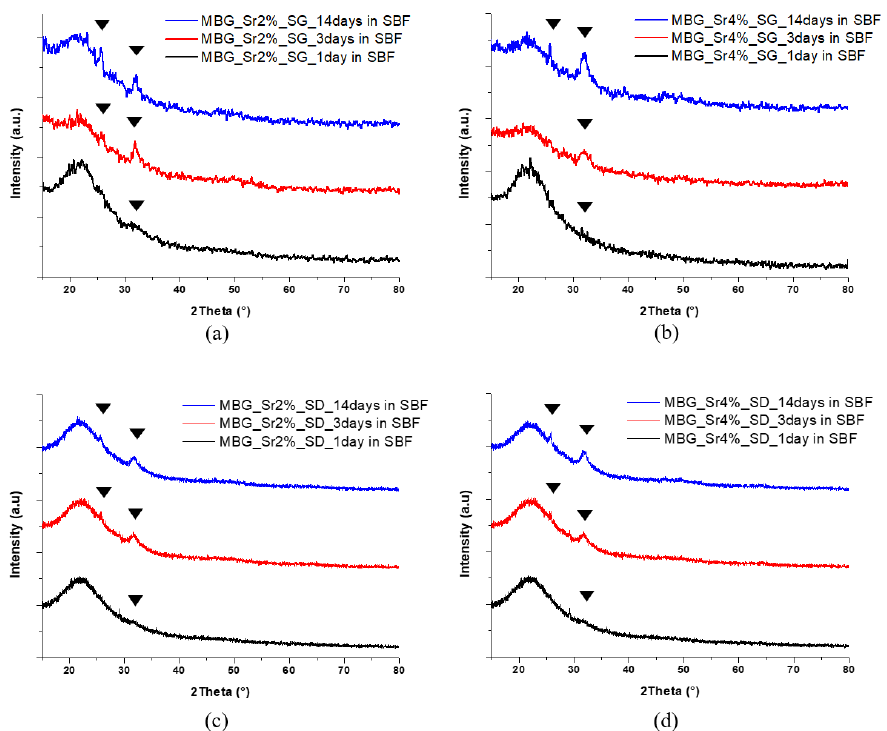
Figure 6. XRD spectra after different time of soaking in SBF of: ( a ) MBG_Sr2%_SG; ( b ) MBG_Sr4%_SG; ( c ) MBG_Sr2%_SD; ( d ) MBG_Sr4%_SD.